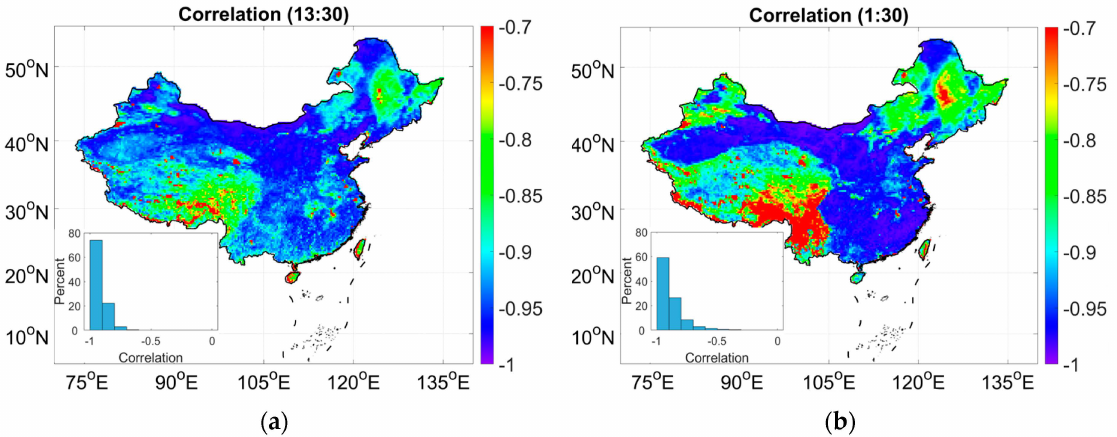
Figure 2. ( a , b ) are correlations of the MODIS LST and freeze/thaw index (FTI) for observations at 13:30 and 1:30,